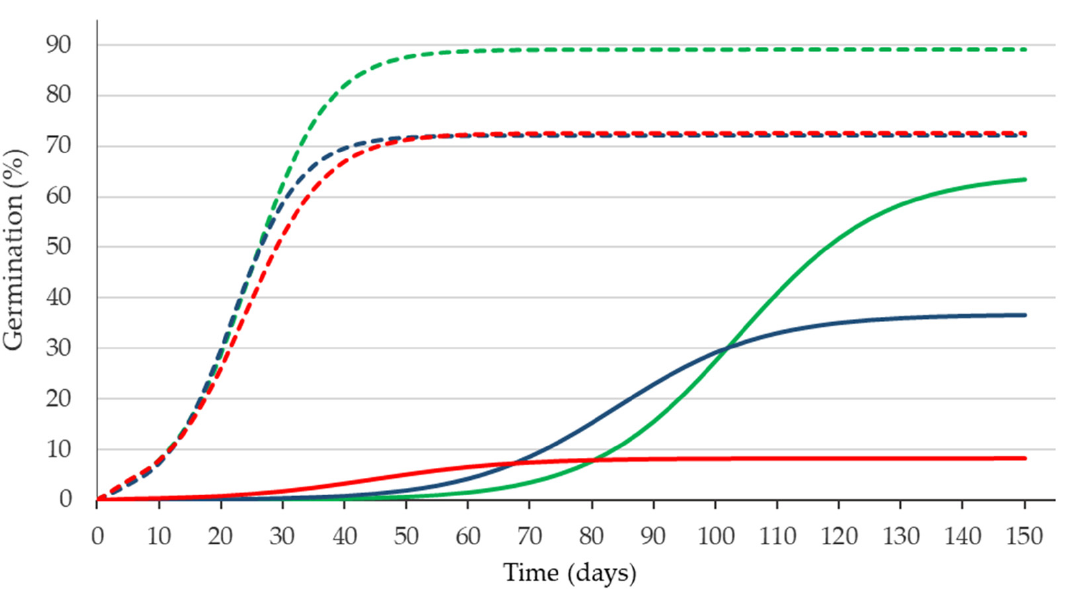
Figure 4. Logistic model fitted to the cumulative germination curves of caper seeds. Mean values for the combination of the state of the seeds (fresh seeds (FS), dried seeds (DS), and stored seeds (SS) in green, blue, and red, respectively) and substrate saturation solution (water in continuous lines and GA 3 solution in dashed lines). Table 6. Effect of the state of the seed (fresh seeds (FS), dried seeds (DS), and stored seeds (SS)) and the substrate saturation solution on the germination parameters: cumulative germination ( G , %), final germination percentage ( A , %), time (d) required to reach 50% of final germination ( Gt 50 ), and average germination rate ( k /2; d − 1 ); mean values.